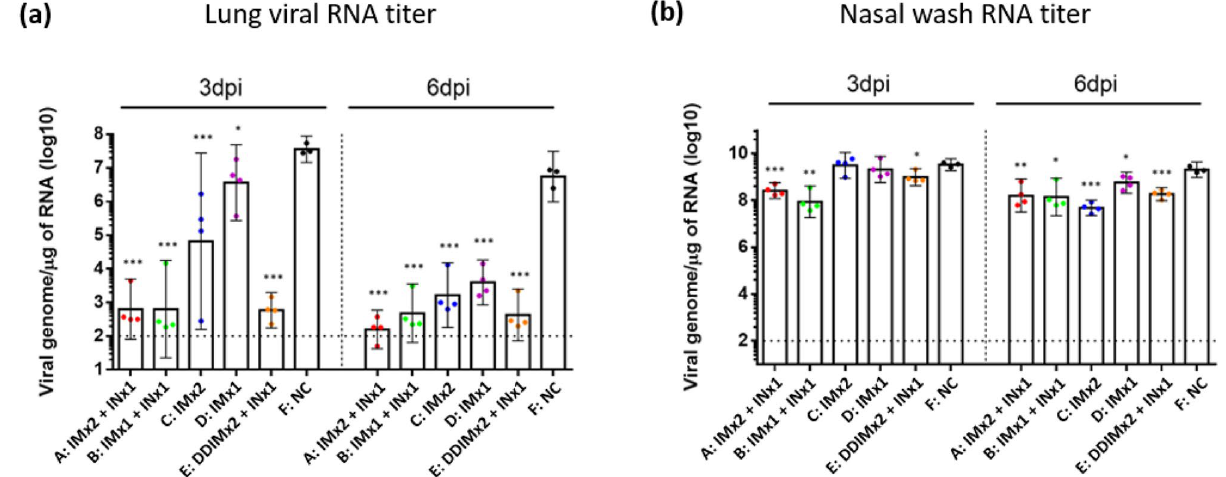
Figure 6. Viral RNA titer of hamster at days 3 and 6 post-SARS-CoV-2 infection. ( a ) lung viral RNA titer; ( b ) nasal wash at days 3 and 6 post-SARS-CoV-2 infection. Results are presented as the geometric mean values. Differences between negative control group and other experimental groups of animals were analyzed by student’s t test; * p < 0.05, ** p < 0.01, *** p < 0.001. Dotted line: limit of detection.